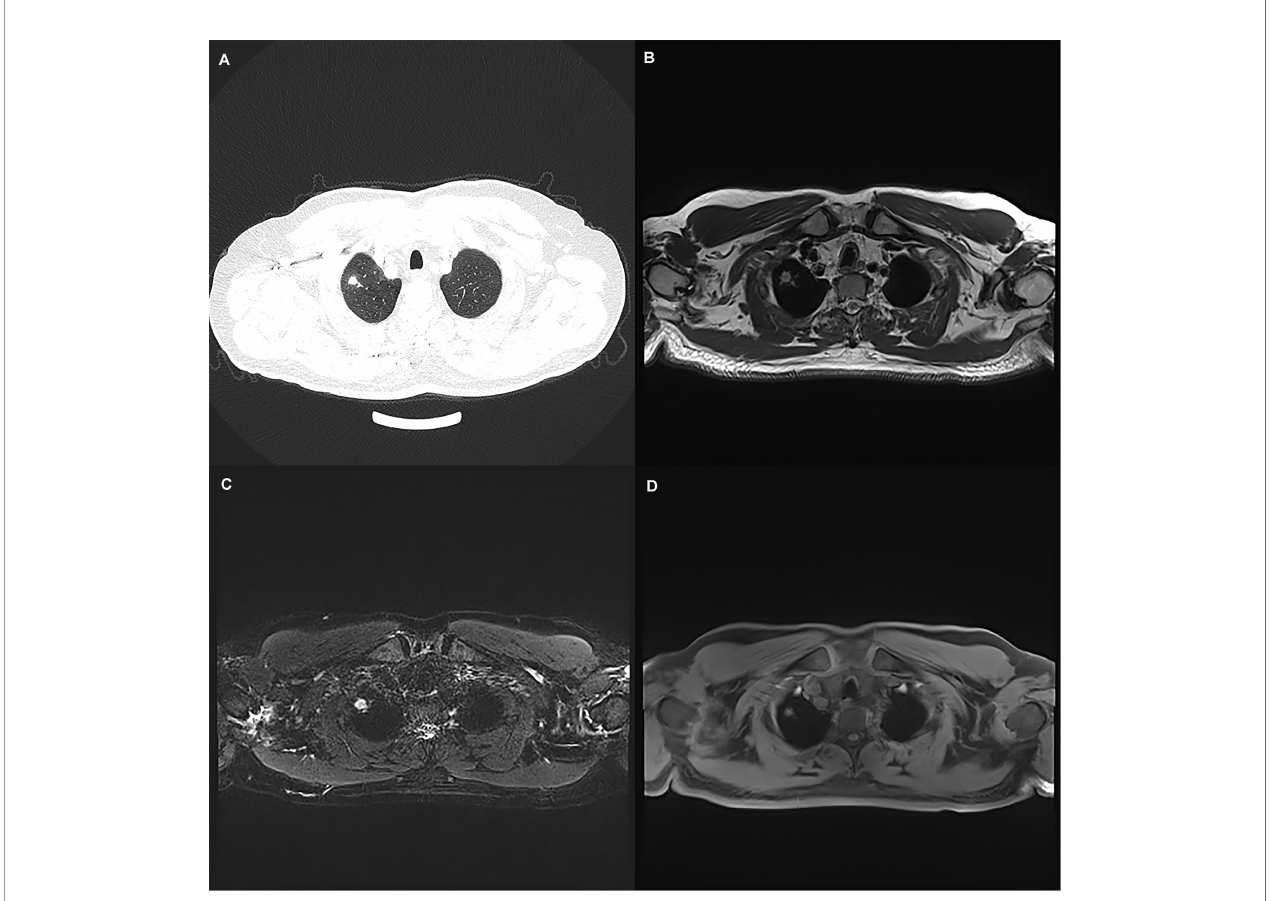
FIGURE 1 | A 50-year-old man with a 7 mm pulmonary solid nodule (arrow) in the right upper lobe. The nodule is clearly seen on the computed tomography image (A) and the images from magnetic resonance image sequences T2-BLADE (B) , T2-HASTE (C) , and T1-Star-VIBE (D) . The arrows represent the location of the